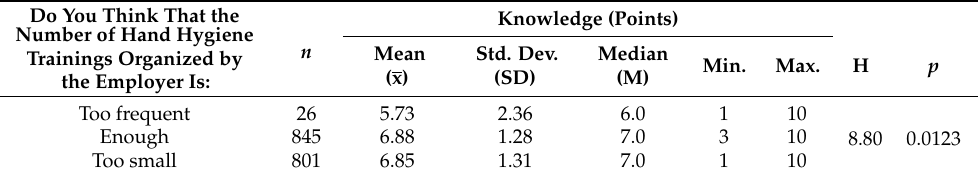
Table 8. Descriptive statistics on the level of knowledge among respondents with different opinions on the number of hand hygiene trainings organized by the employer and the Kruskal–Wallis test results